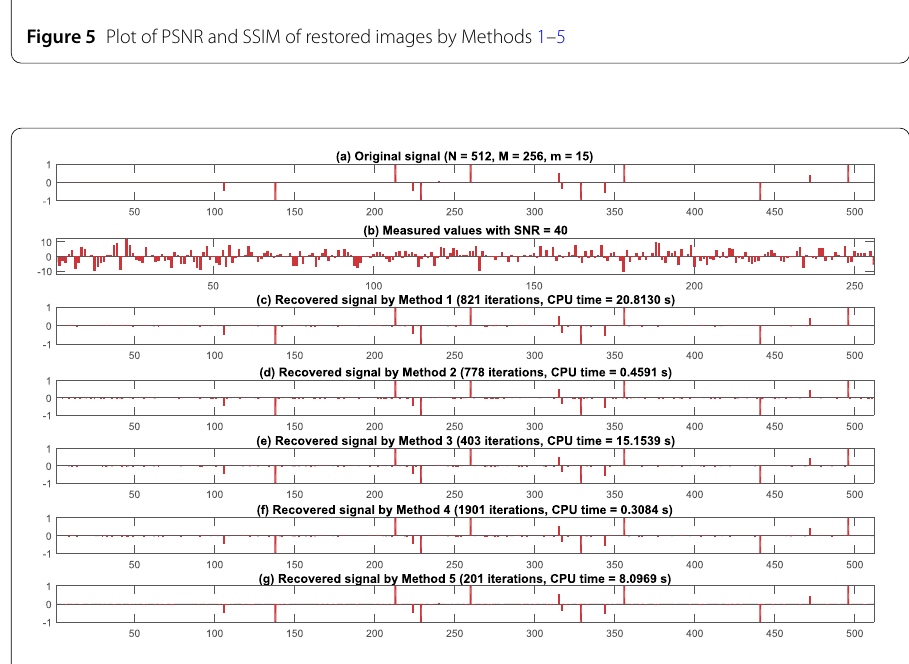
Figure 6 Signal recovery in case of N = 512, M = 256, m = 15. ( a ) Original signal; ( b ) Observed data; ( c )–( g ) Recovered signals by Methods 1–5